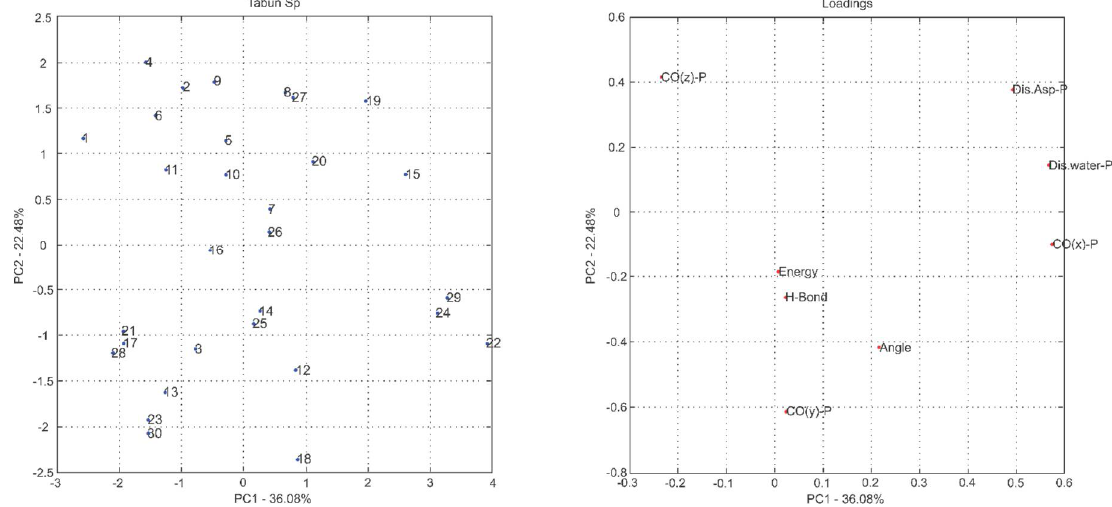
Figure 9. PC1 versus PC2 projection for Tabun ( S P enantiomer) and loadings graph of the variables investigated ( left and right , respectively).